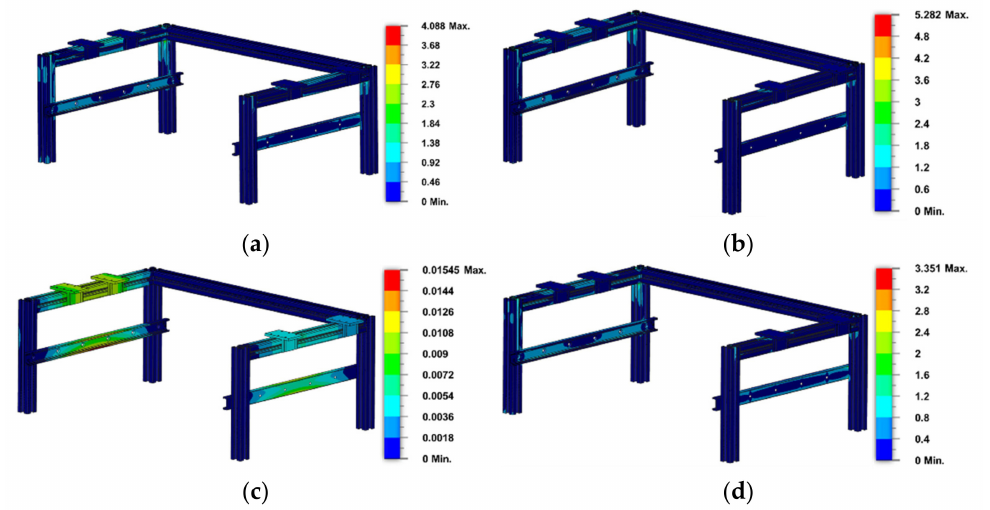
Figure 8. Contour of Von Mises Stress on Overhead Crane: ( a ) Standard Type; ( b ) Lightweight Type; ( c ) Economy Type; ( d ) High-Rigidity